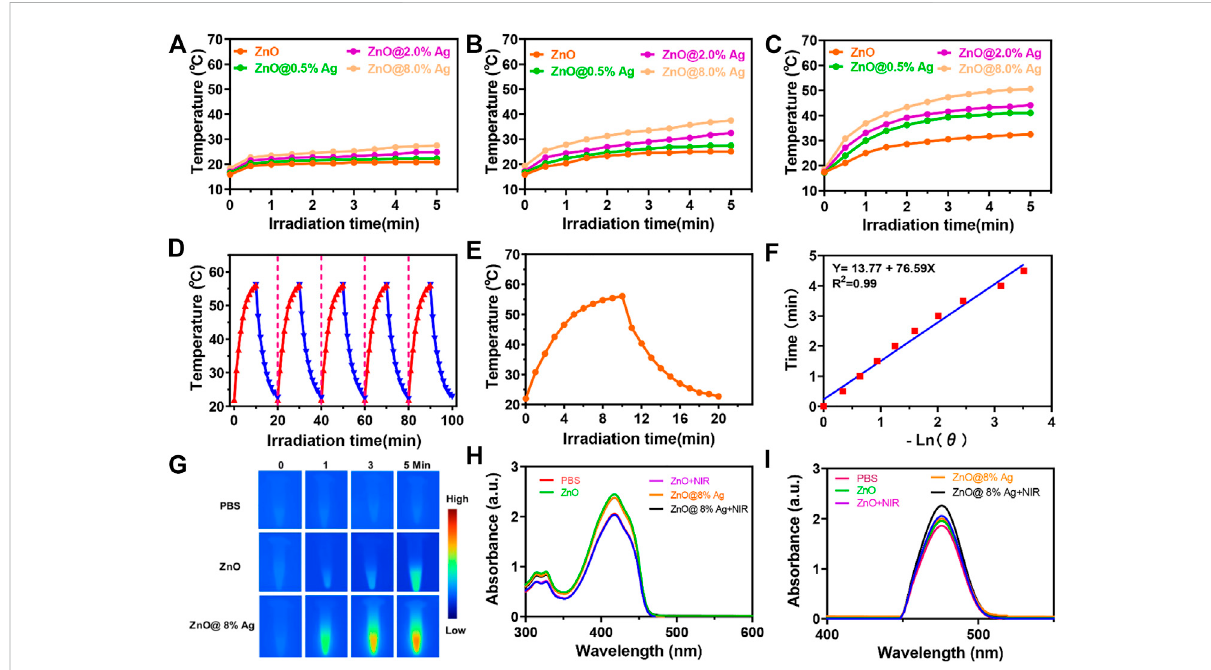
FIGURE 2 Activatable NIR photothermal and photodynamic properties of ZnO@8%Ag. (A) Temperature elevation curves of ZnO and ZnOAg with varying ratios of Ag (0.2%, 0.5%, and 8%) under NIR irradiation (808 nm, 0.5 W/cm 2 , 5 min), (B) photothermal evolution curves of ZnO and ZnO@Ag with varyingratiosofAg(0.2%,0.5%,and8%)underNIRirradiation(808 nm,1 W/cm 2 ,5 min), (C) temperaturevariationsofZnOandZnO@Agwithvarying ratios of Ag (0.2%, 0.5%, and 8%) under NIR irradiation (808 nm, 2 W/cm 2 , 5 min), (D) recycling heating pro fi les of ZnO@8%Ag under irradiation for fi veon/offcycles, (E) heatingandcoolingofZnO@8%AgunderNIRirradiation(808 nm,2 W/cm 2 ,5 min), (F) linearcorrelationofthecoolingtime of ZnO@8%Ag, (G) thermal images of PBS, ZnO, and ZnO@8%Ag under NIR irradiation (808 nm, 2 W/cm 2 , 5 min), (H) UV spectra following the absorption of DPBF in PBS, ZnO, and ZnO@8%Ag with/without NIR irradiation (808 nm, 2 W/cm 2 , 5 min), and (I) spectra of changes for the absorption of OPD in PBS, ZnO, and ZnO@8%Ag with/without NIR irradiation (808 nm, 2 W/cm 2 , 5 min).